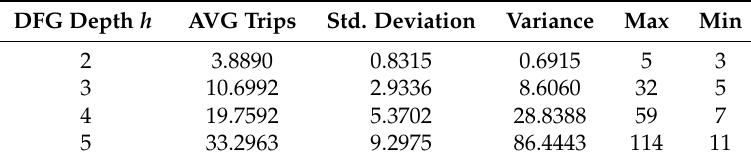
Table 4. Average number of trips per DFGs with our